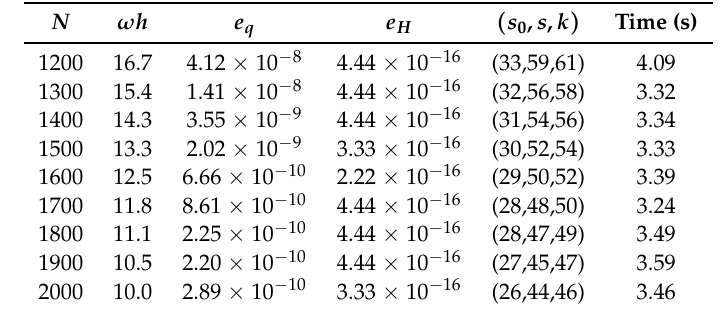
Table 4. Duffing problem (112)–(115) solved by the SHBVM ( k , s , s 0 ) method with parameters (116) and time-step h = 20/ N : e q is the maximum absolute error in the computed solution; e H is the maximum relative error in the numerical